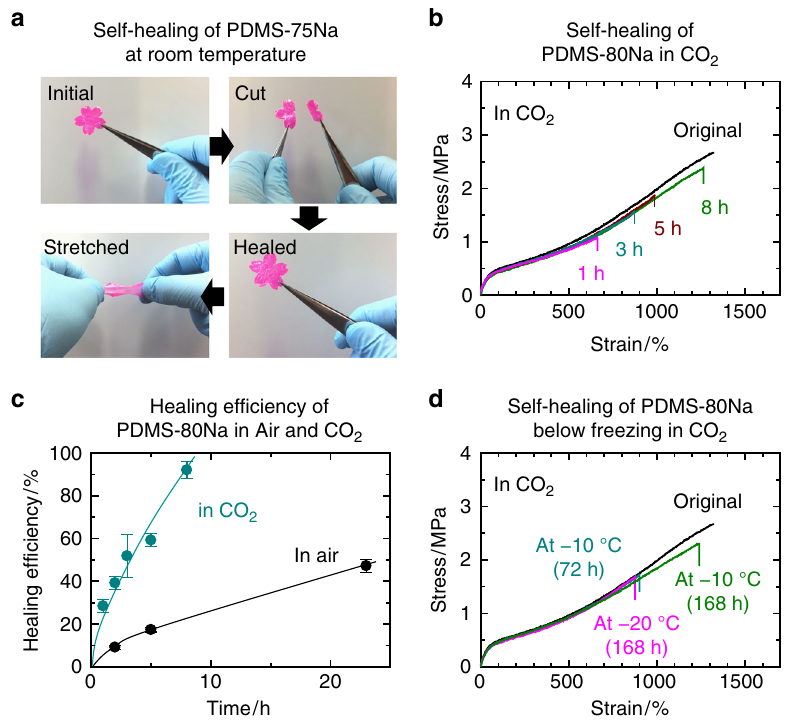
Fig. 4 Effect of CO 2 on self-healing of PDMS- x Na. a Photograph of self-healing behavior of cherry blossom-shaped PDMS-75Na fi lm at 26 °C. The fi lm was painted pink. b Stress – strain curves of PDMS-80Na healed at 26 °C in CO 2 . c Time variation of healing ef fi ciency of PDMS-80Na stored at 26 °C in air and in CO 2 . The error bars indicate standard deviations. d Stress – strain curves of PDMS-80Na healed at − 10 °C and − 20 °C in CO